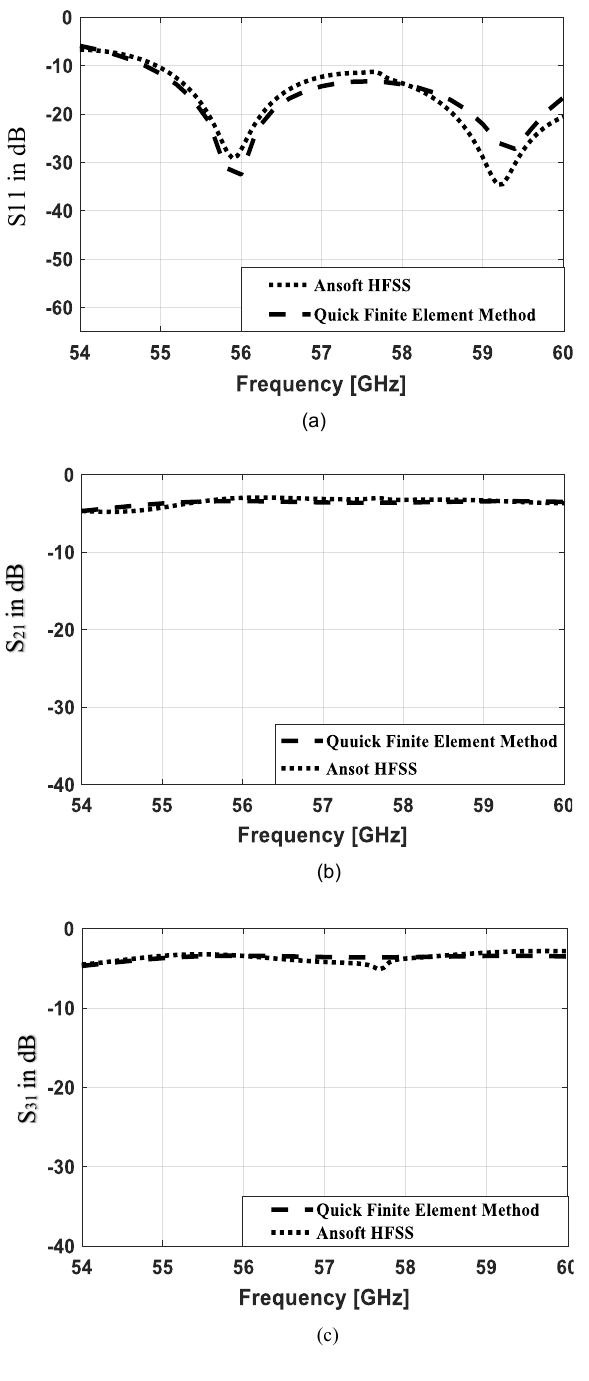
FIGURE 3. Results for 1 × 2 power divider with chamfered bend, (a) Reflection coefficients S11, (b) (c) Transmission coefficients S12 and S13. According to the simulation comparison results provided in Figure 3. Reflection coefficients and transmission we see good consistency is obtained between the two results of QFEM and Ansoft HFSS. It should be noted that two peaks provided by QFEM at 55.9 GHz and 59.2 GHz were given by HFSS. Both graphs show that the transmission is only possible from 54 GHz; this is clear in Figures 3. (b) and (c).